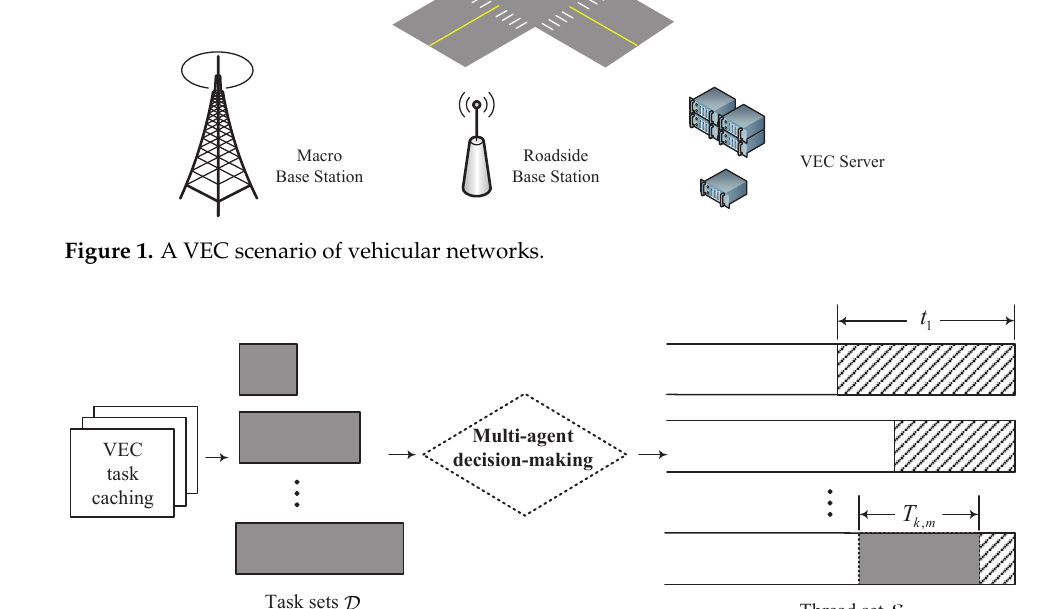
Figure 2. The DRL-based framework of task scheduling in the VEC